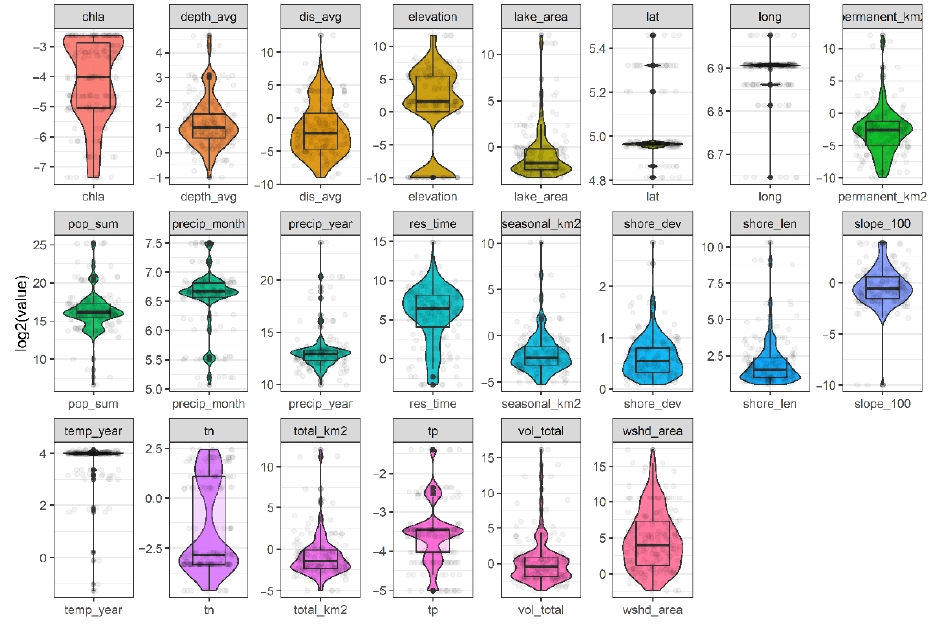
Figure 2. Violin chart of the lake parameter data distribution.